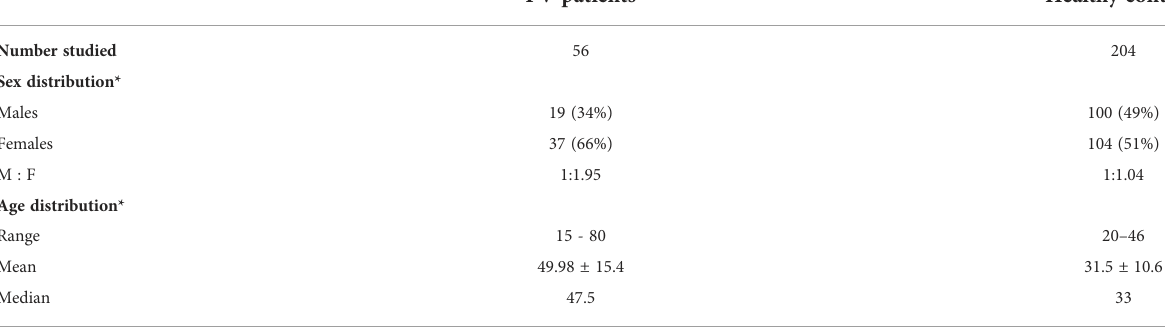
TABLE 2 Demographic and clinical data. PV patients and healthy controls from the Bulgarian